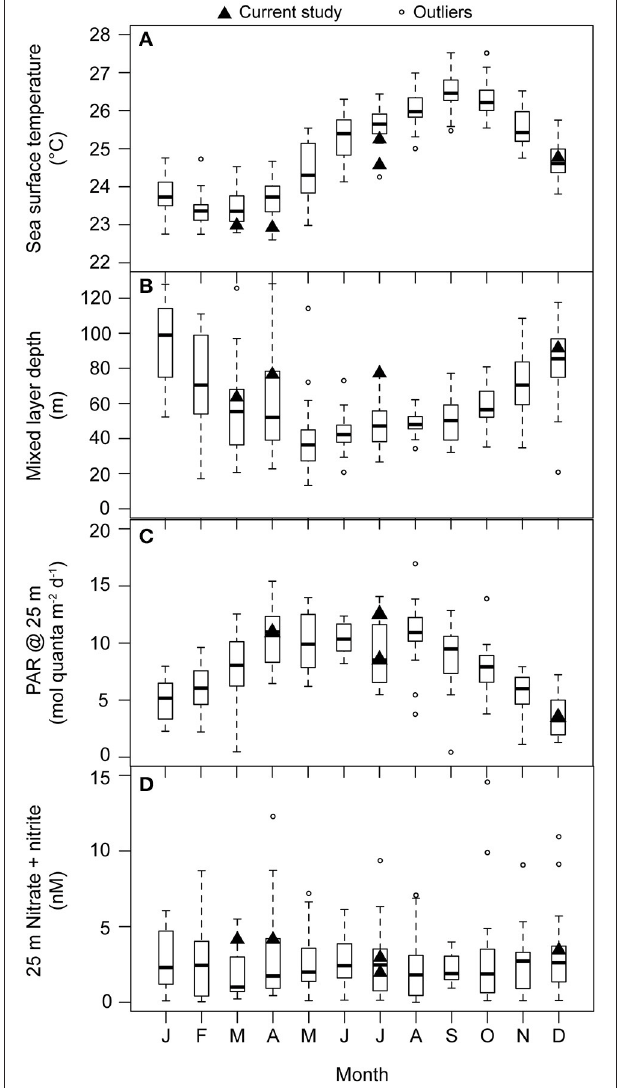
FIGURE 1 | Monthly-scale variability in (A) sea surface temperature ( ◦ C; 1988–2014), (B) mixed layer depth (m; 1988–2014), (C) daily integrated PAR at 25m (mol quanta m − 2 d − 1 ; 1998–2013), and (D) concentrations of N + N at 25m (nM N; 1989–2013) at Station ALOHA. Measurements from the research cruises during which experiments for the current study were conducted are denoted with black triangles. For each boxplot: dark horizontal line indicates the median, the box boundaries represent the 25th and the 75th percentile, and the whiskers extend to the maximum and minimum (boundary ± 1.5*interquartile range) of the selected observations. Outlier observations, considered to be beyond the maximum and minimum limits of the observations, are depicted as open